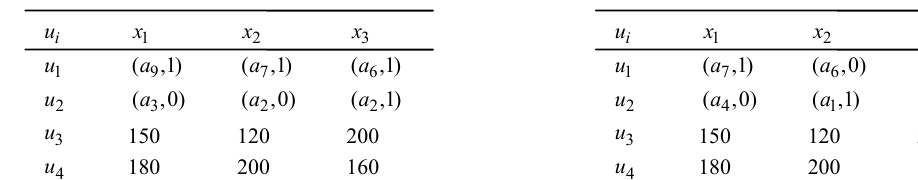
d Table 2. Preference information given by decision 1